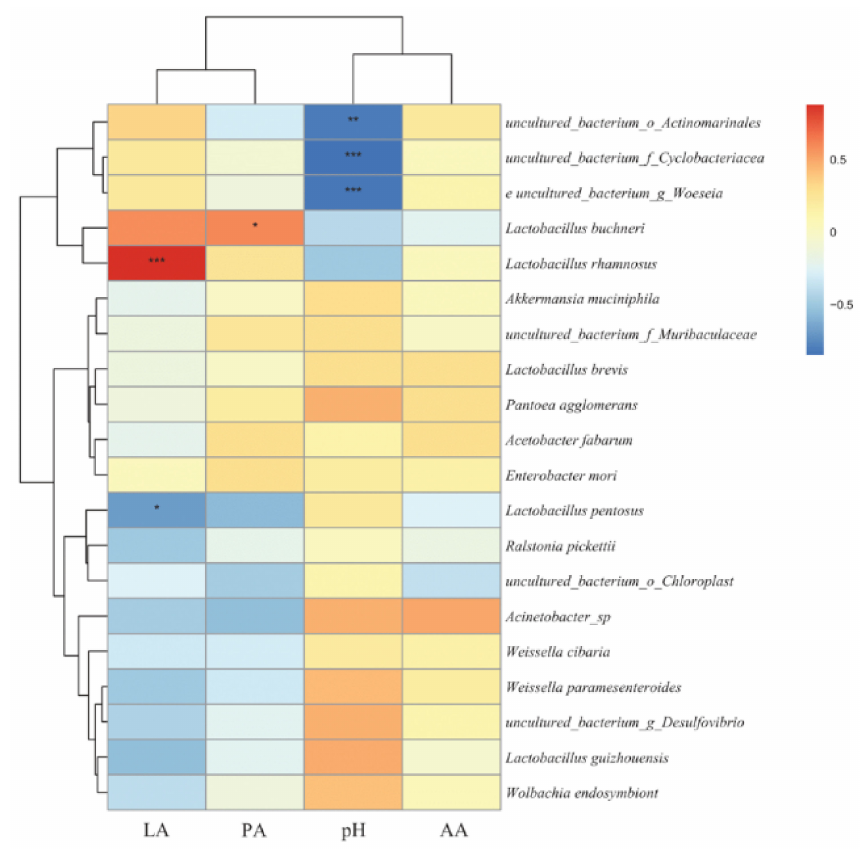
Figure 2. Correlations between fermentation characteristics and microbial community. * significance at p < 0.05; ** significance at p < 0.01; *** significance at p < 0.001.